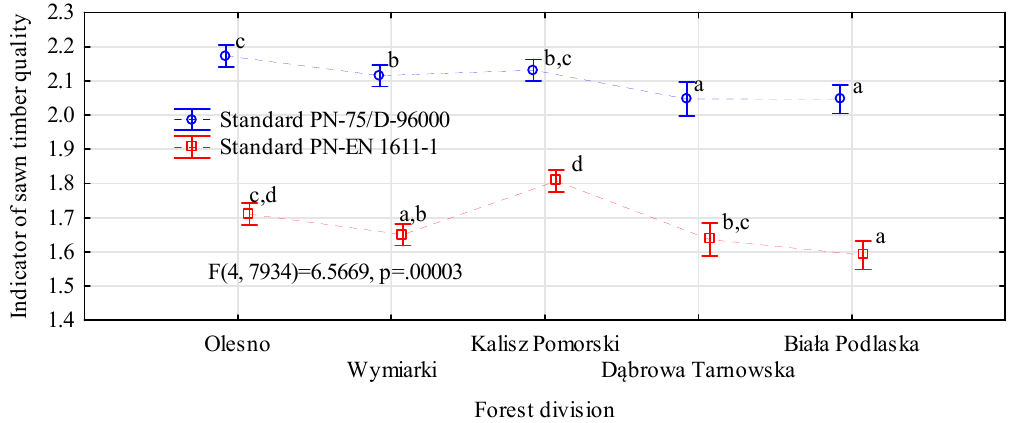
Figure 5. A comparison of the quality of sawn timber graded based on the Polish Standard and the European Standard for timber from di ff erent sites (the letters denote homogeneous groups as found in the Tukey’s test for di ff erent forest divisions). Table 13. The percentage of knots as a factor a ff ecting the quality class of sawn timber in the longitudinal section of long logs.